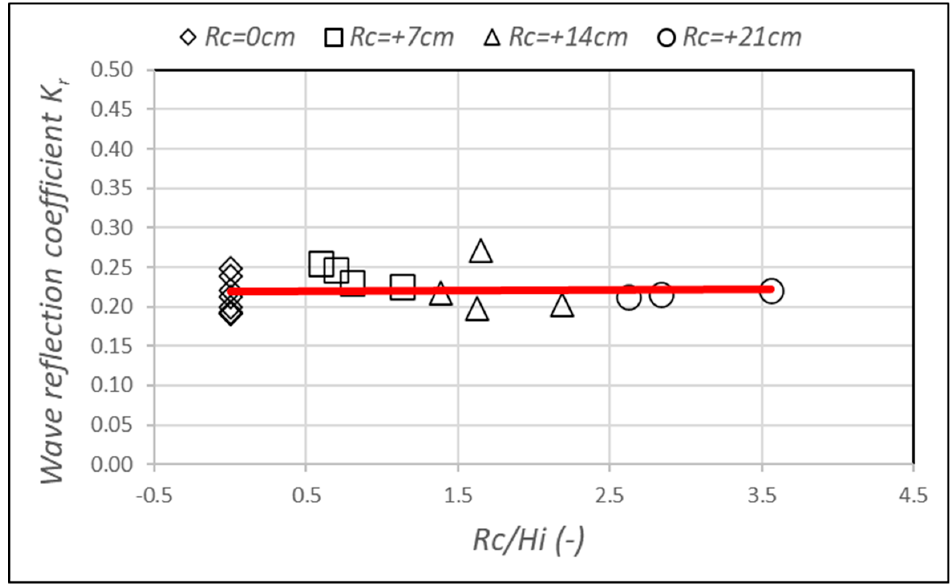
Figure 15. Influence of the crest freeboard on the wave reflection coefficient K r .